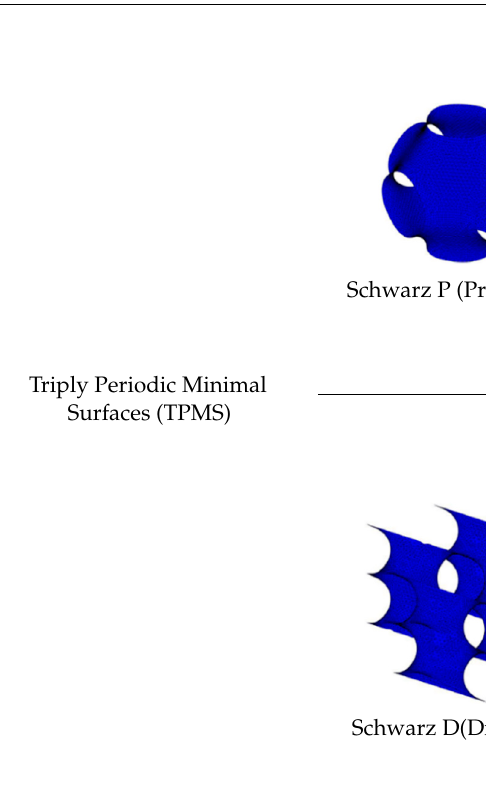
Table 2. Parametric design and its